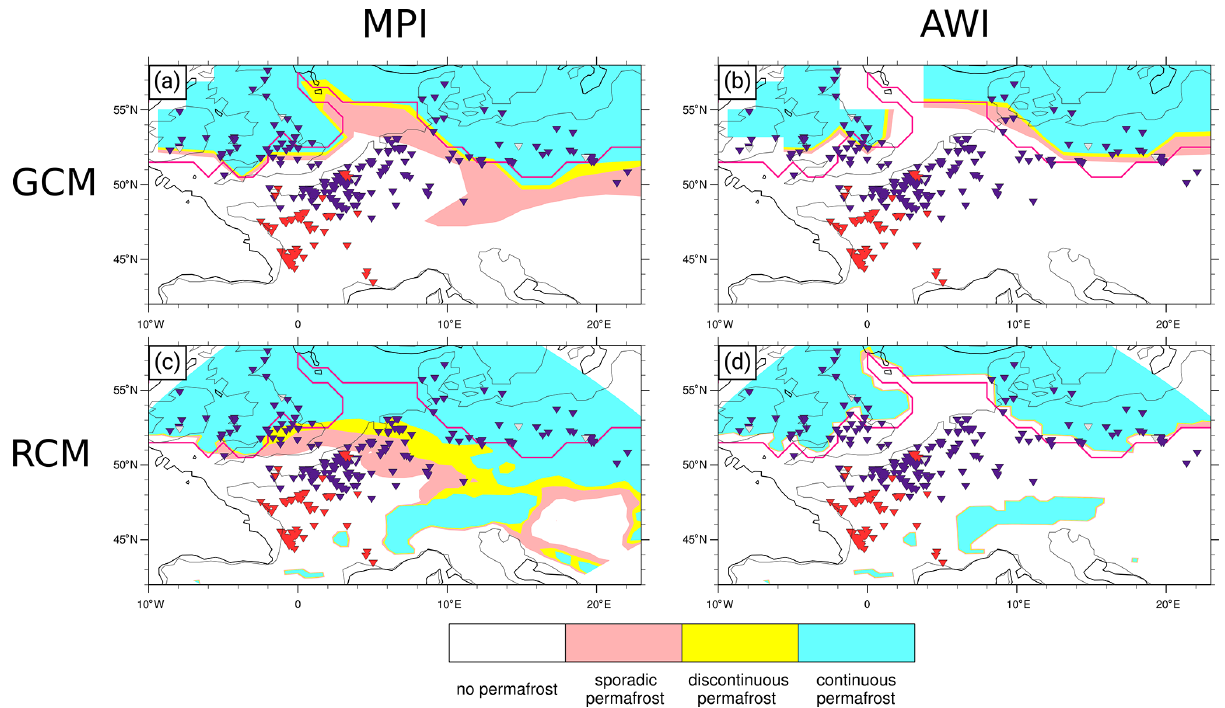
Figure 6. Permafrost distribution based on the surface frost index (SFI) at approximately 70cm depth as simulated by the global MPI (a) and the global AWI (b) simulations and their respective regional counterpart ( c and d ). Ice-wedge pseudomorphs, composite wedges, and sand wedges from Andrieux et al. (2016) and Isarin et al. (1998) are denoted by the purple, grey, and red triangles respectively. The black line shows the LGM coastline, and the pink line denotes the LGM ice